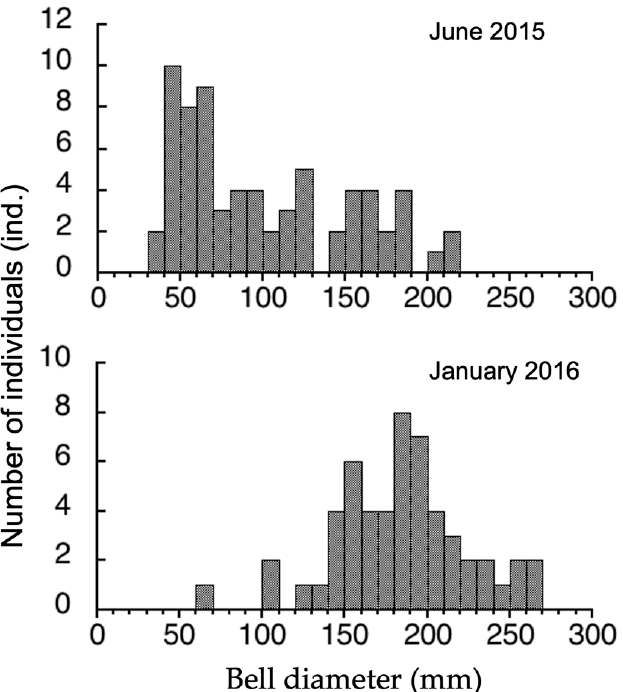
Figure 5. Size distribution of Acromitus hardenbergi medusae collected in June 2015 and January 2016.